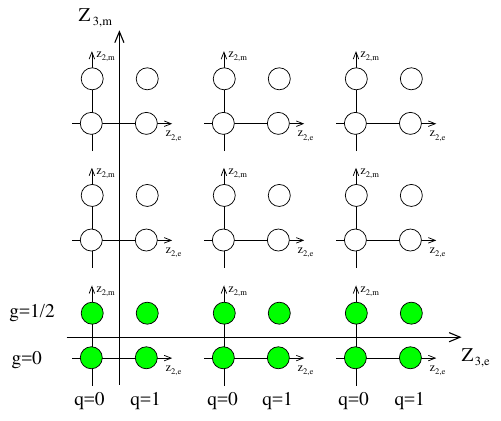
Figure 3 . (cid:0) = Z 2 . The Abelian lines are generated by ( q; g ) = (2 ; 0) and (0 ; 1).